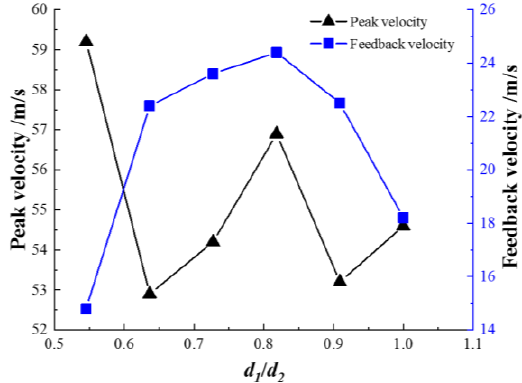
Figure 10. Curves of peak velocity and feedback velocity vs inlet diameter.